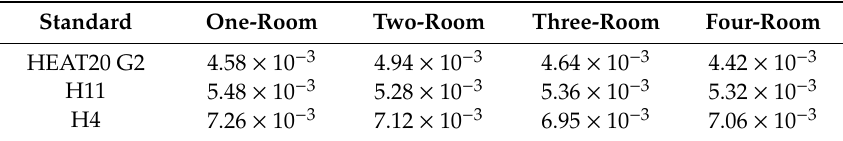
Table 4. Summary of average residuals ( δ ) (K) for simulation